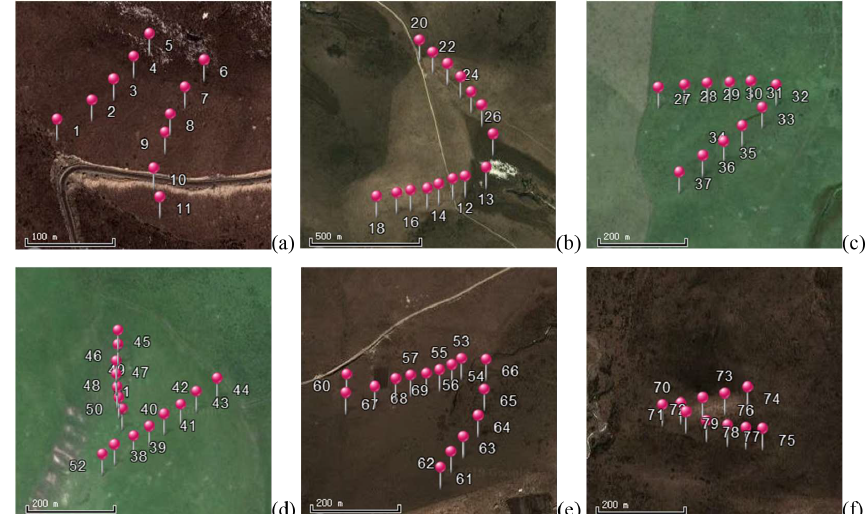
Figure 4. Panels (a) , (b) , (c) , (d) , (e) , and (f) are the exact locations of soil thickness measurements at the sites a, b, c, d, e, and f, respectively, shown in Fig. 3, in the .KML-formatted image from © Google